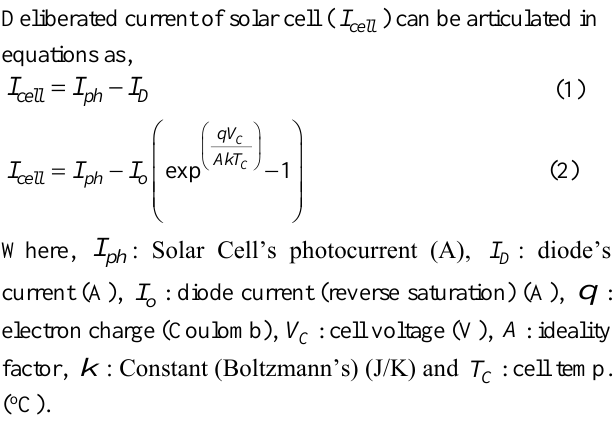
Deliberated current of solar cell ( equations